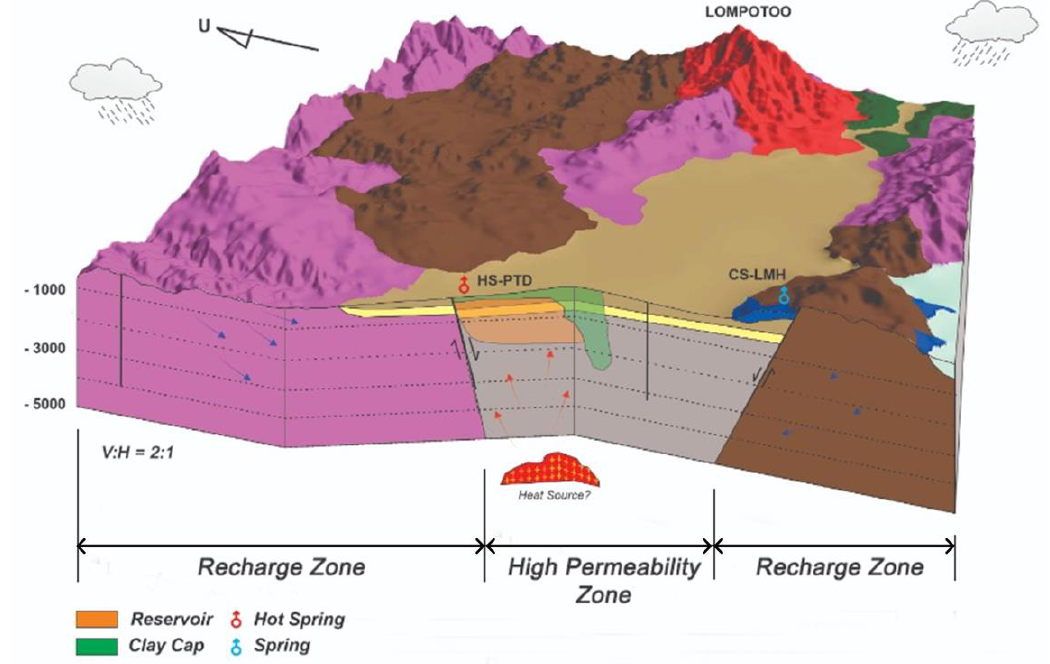
Figure 12. A conceptual model of Limboto Lake — Pentadio derived from the 3D MT resistivity model, 2D gravity forward modeling, and geological studies.